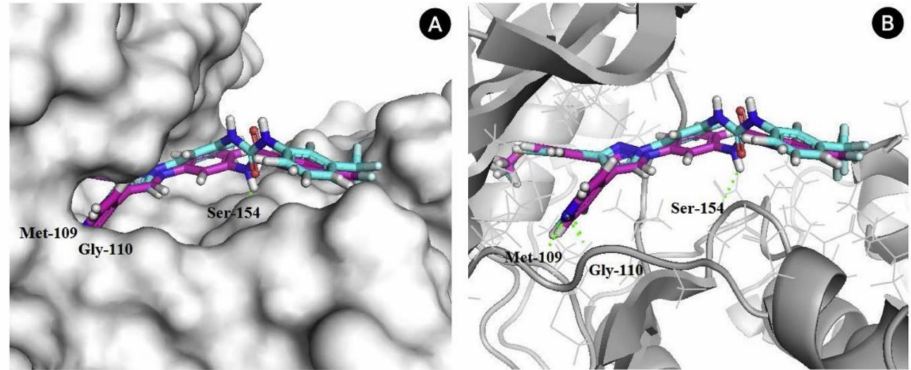
Figure 64. Binding mode of urea and amide derivatives; ( A ) binding mode of a urea compound (one of the compounds in the series, cyan) and 57 (magenta, amide), ( B ) best-docked pose for another two derivatives within the p38 α kinase active site. Green dotted lines illustrate hydrogen bonding interactions [69].